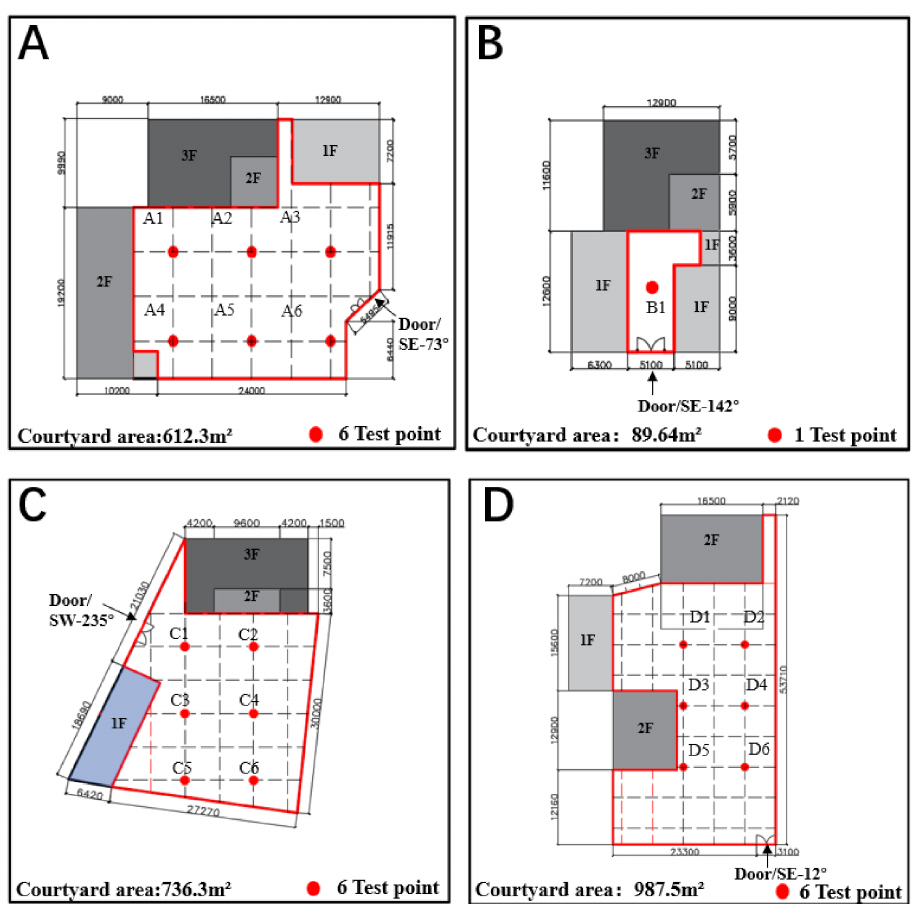
Figure 5. Four types of representative courtyards. (( A – D ) respectively represent the number of the courtyard under